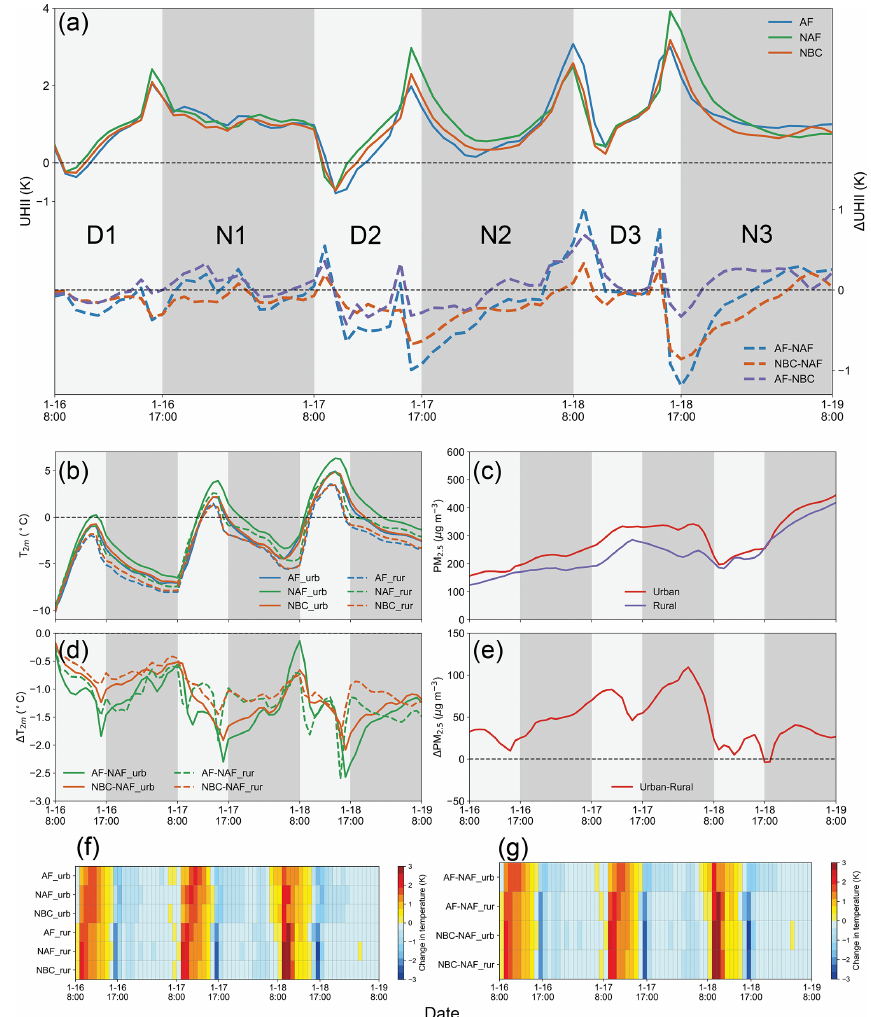
Figure 4. Variations of UHII sim of all cases and differences between them (a) in case_2010. Variations of T 2m (b) and (cid:49)T 2m (d) in urban and rural areas. Variations of PM 2 . 5 (c) and (cid:49) PM 2.5 (e) in urban and rural areas of AF case. Hourly changes in T 2m (f) and (cid:49)T 2m (g) in urban and rural areas, where AF-NAF represents the influence of ARE on UHII, NBC-NAF represents the influence of ARE on UHII by all aerosols but BC and AF-NBC represents the influence of BC absorption on